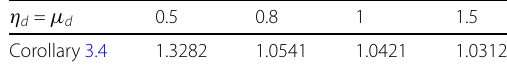
Table 2 The MAUBs of η 2 = μ 2 for different η d = μ